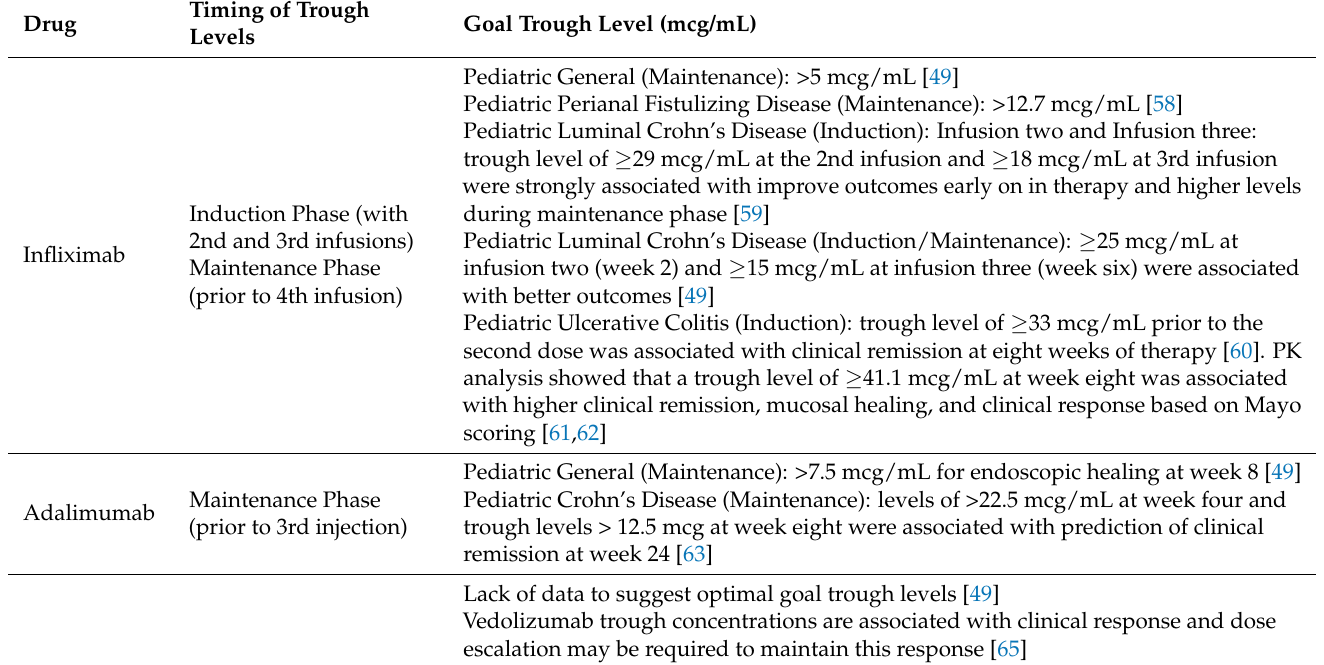
Table 2. Therapeutic Drug Monitoring (TDM) for Monoclonal Antibodies and Calcineurin Inhibitors in